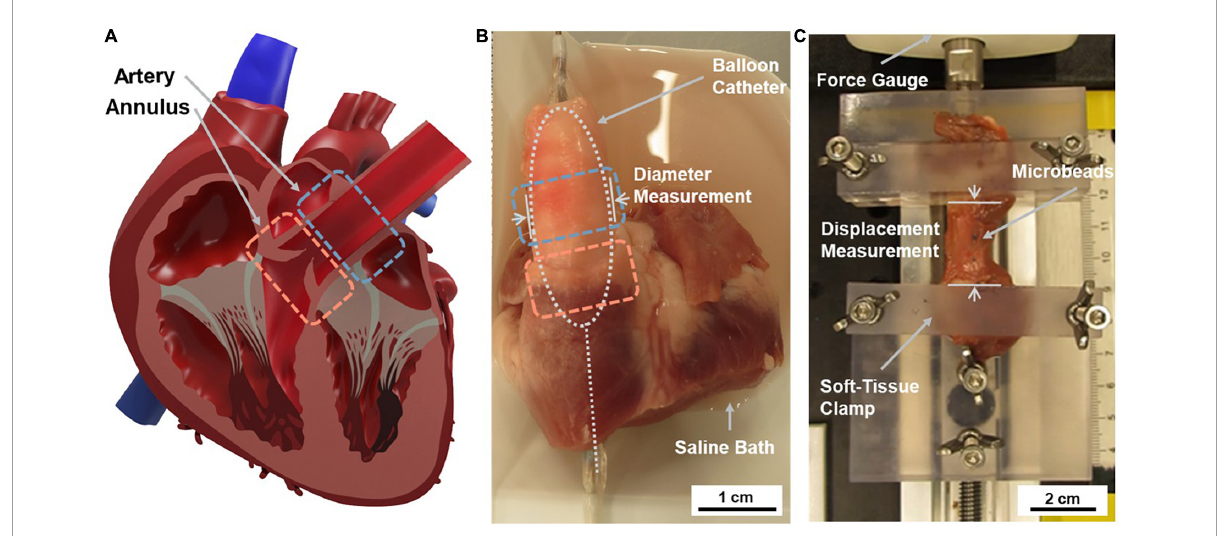
FIGURE1 Overview of testing regions of interest and applied tissue testing techniques. (A) Tissue samples were sourced from the pulmonary artery (PA) and pulmonary valve (PV) annulus region. (B) The radial testing system applied stress to the intact cardiovascular structure using a fluid-filled balloon catheter placed inside the heart. Data was collected using a pressure sensor connected to the balloon catheter system and image analysis of diameter changes. (C) The uniaxial testing system applied stress to an isolated circumferential tissue sample at a constant extension rate. Data was collected using force gauge readings and associated displacement